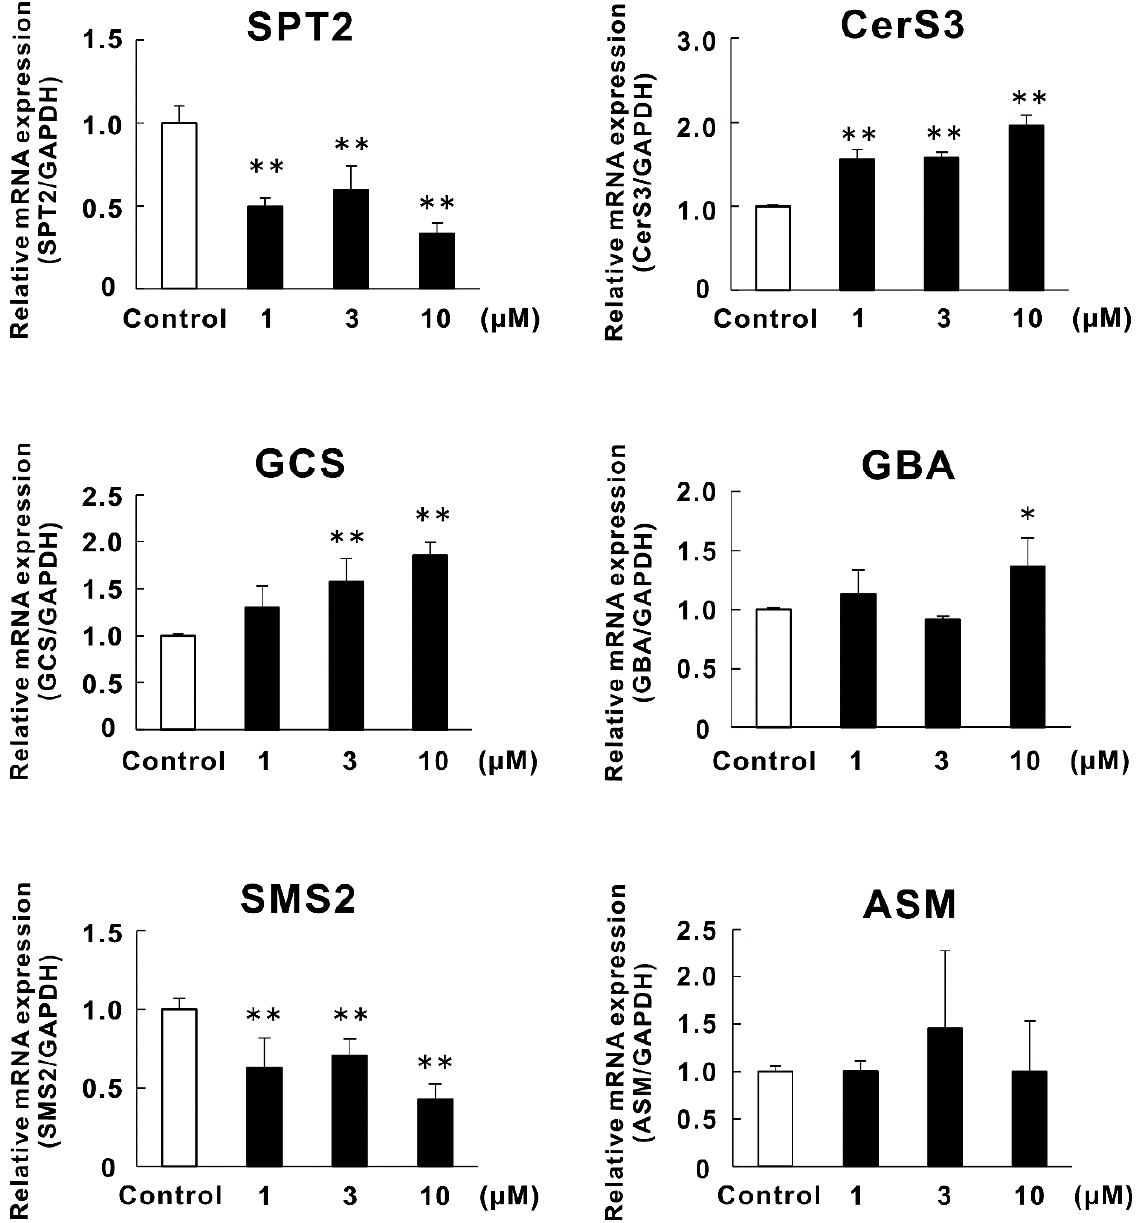
Figure 4. Effects of lycoperoside H ( 3 ) on the mRNA expression of enzymes related to SC ceramide synthesis. RHEK models were treated for 4 days in culture with 1, 3, and 10 µM of lycoperoside H ( 3 ). Extraction of total RNA and real-time RT-PCR analysis was performed as described in the Materials and Methods section. Data are expressed as mean ± SE ( n = 3). * p < 0.05, ** p < 0.01 vs. control.